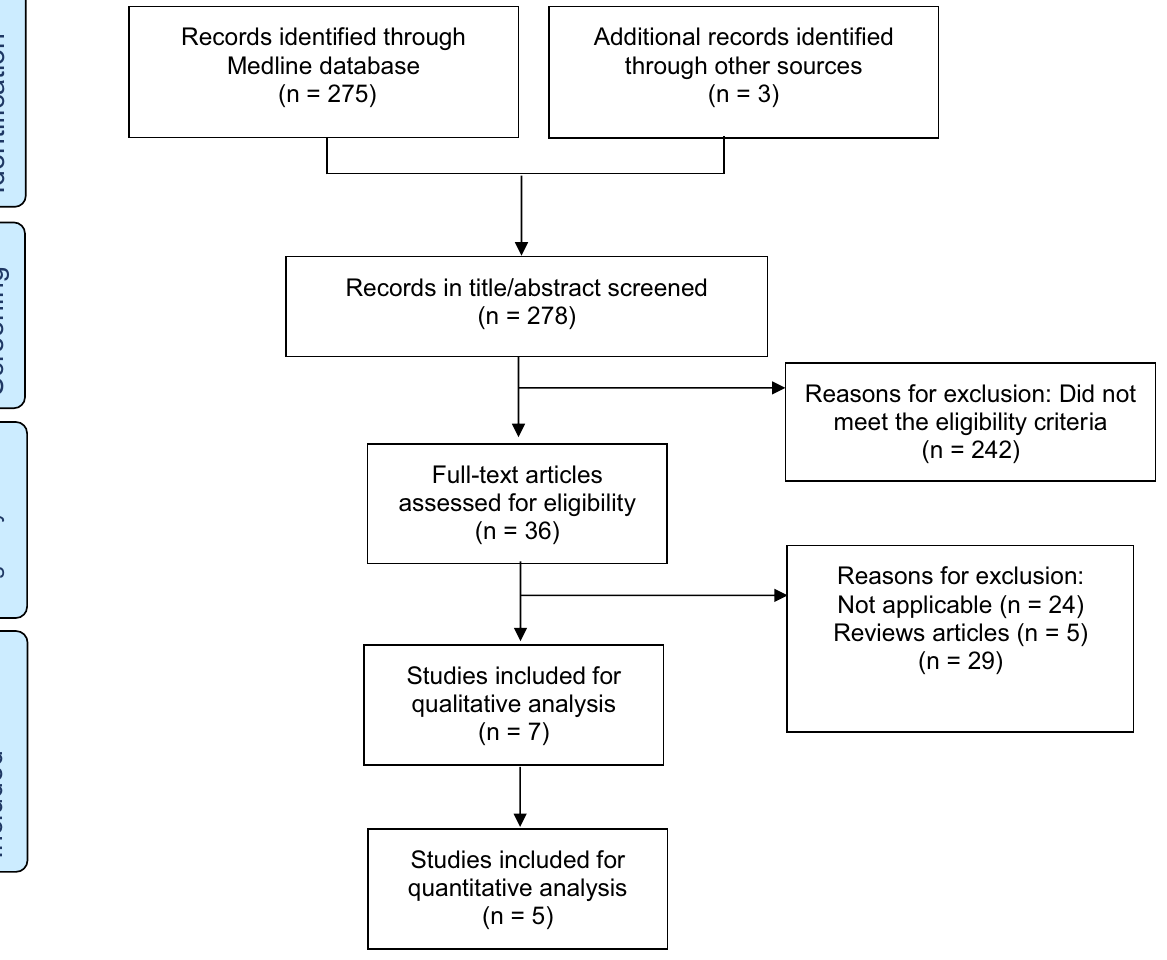
Figure 5. Flow diagram of the search and inclusion process.